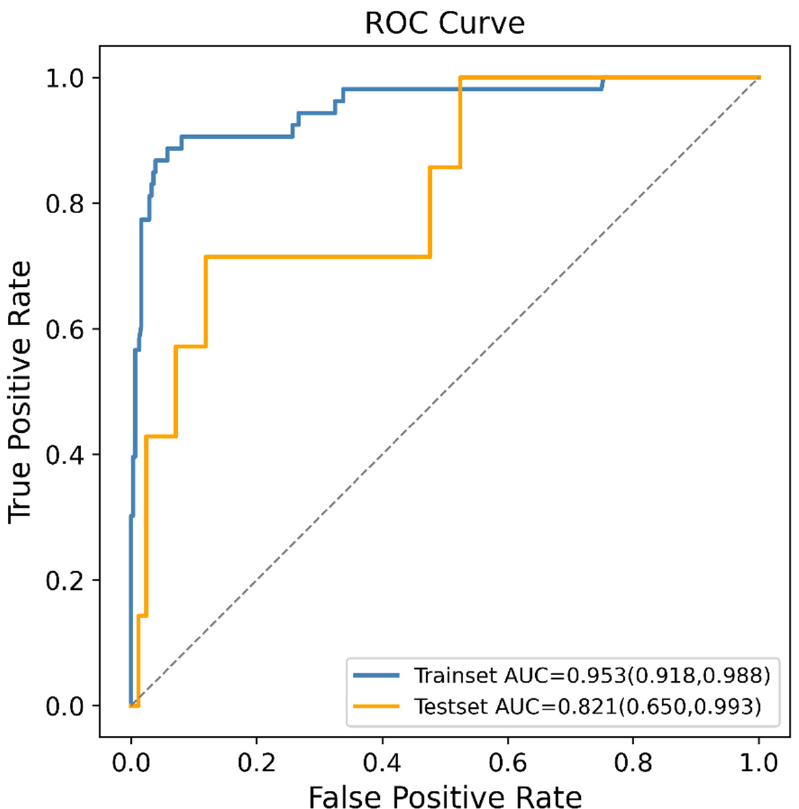
Figure 3. Receiver operating characteristic (ROC) curves of the final machine learning (ML) model generated after recursive feature elimination (RFE) in predicting small for gestational age (SGA).